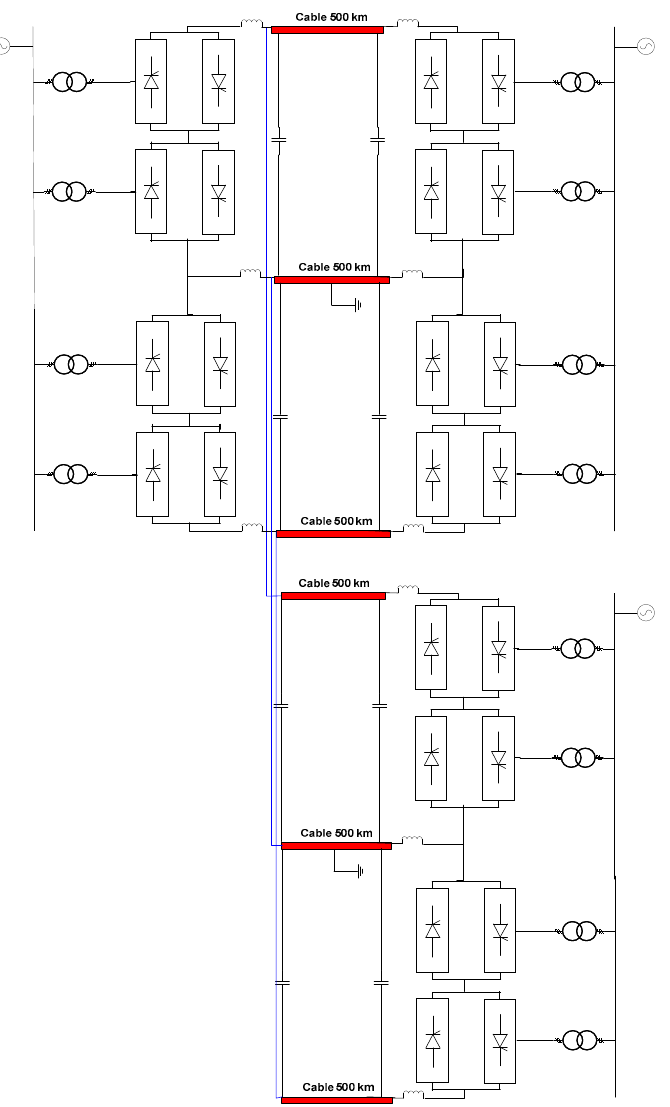
Figure 16. Three-terminal two-phase LFAC.